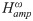
Simulation for PF model.The figure displays the results averaged over 100 iterations for the PF model in simulation. The left hand panel and the right hand panel correspond to differing values of Hurst exponent of the process sampled. In each case Hampω and ρDCCA(n) are estimated and averaged. The trace corresponds to ρDCCA(n) whereas Hampω is displayed in text. See Section: Results: Simulations: PF model.